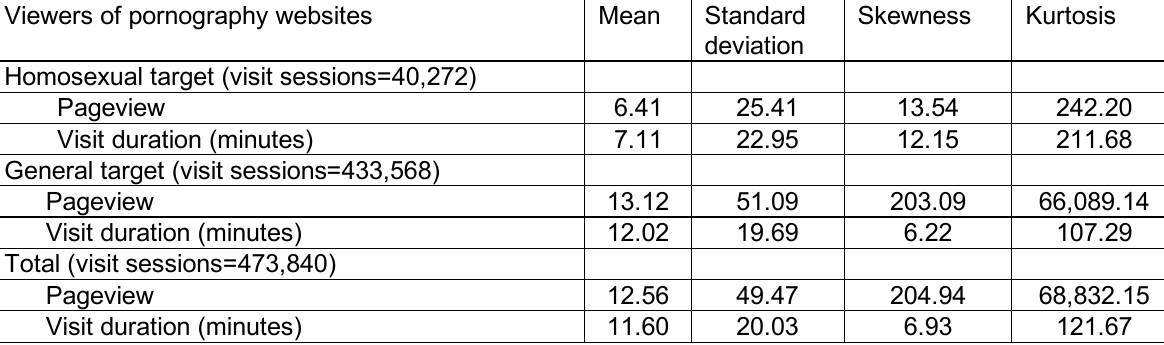
Table 1: Descriptive statistics of pageview and visit duration classified by targeted viewers of pornography websites